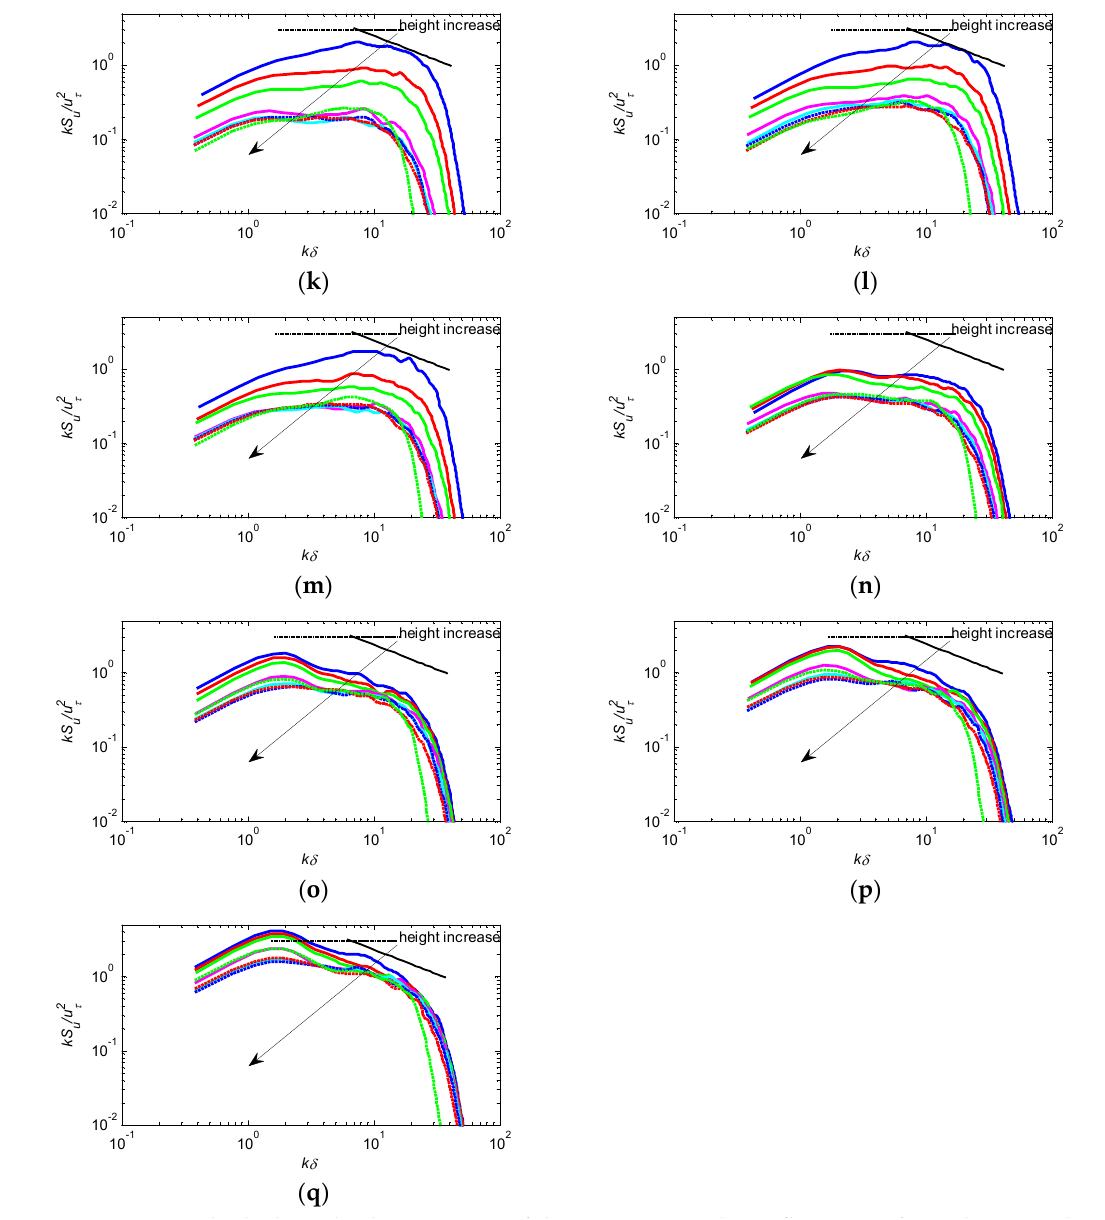
Figure 6. Pre‐multiplied wind velocity spectra of the streamwise velocity fluctuation for each case at different heights: ( a ) to ( q ) are for cases 1 to 17, respectively. The dashed and solid black lines represent 0 and –2/3 slope, respectively.